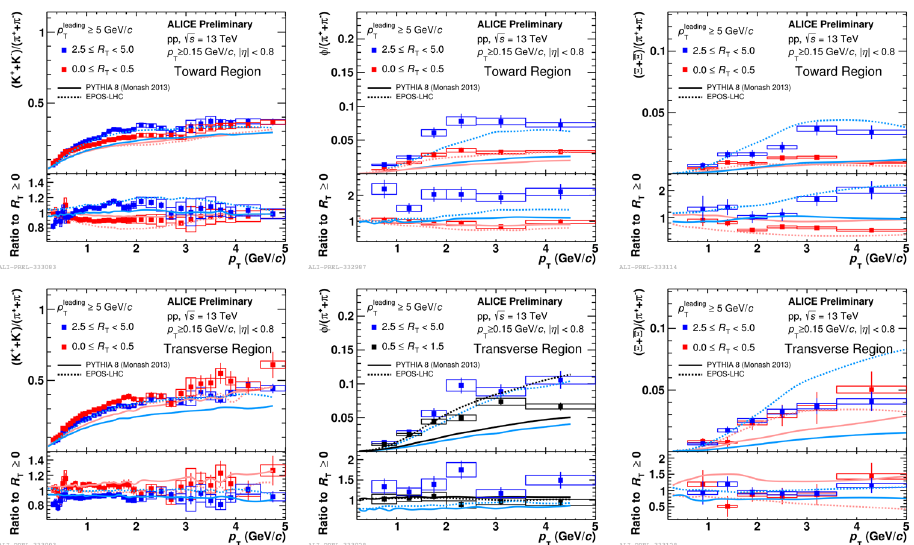
Figure 2: K -to- π (left), φ -to- π (middle) and Ξ -to- π (right) ratios as a function of p T in bins of low- R T (red, black) and high- R T (blue) events. The upper / lower rows showcases the Toward and Transverse regions, respectively. The lower panels in each plot show the ratios to R T - integrated. The results are compared to predictions from PYTHIA8-Monash (solid lines) and EPOS-LHC (dashed